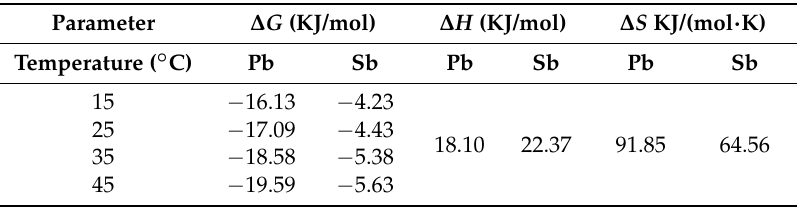
Table 4. Thermodynamic parameters under different temperature.